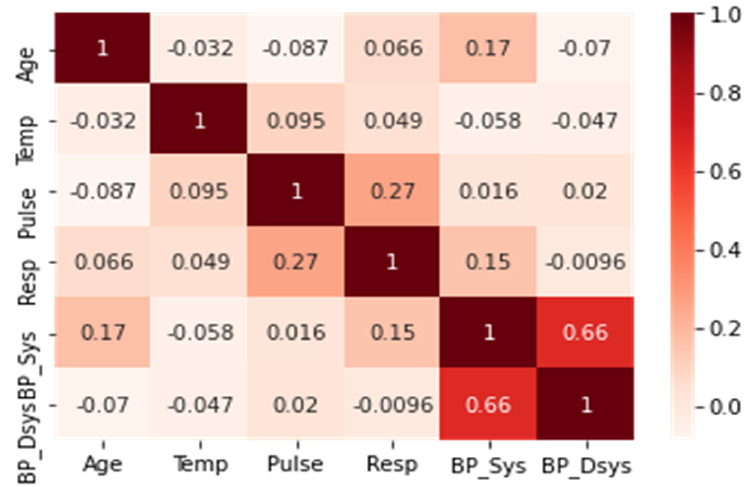
Figure 2. Correlation of the numeric attributes in the dataset.